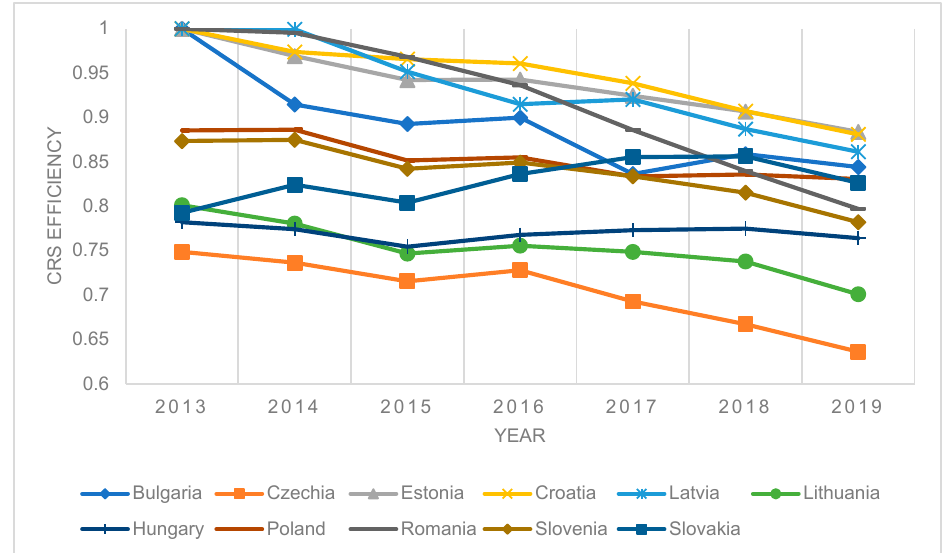
Figure 2. Results of DEA window efficiency measurement—CRS model, selected